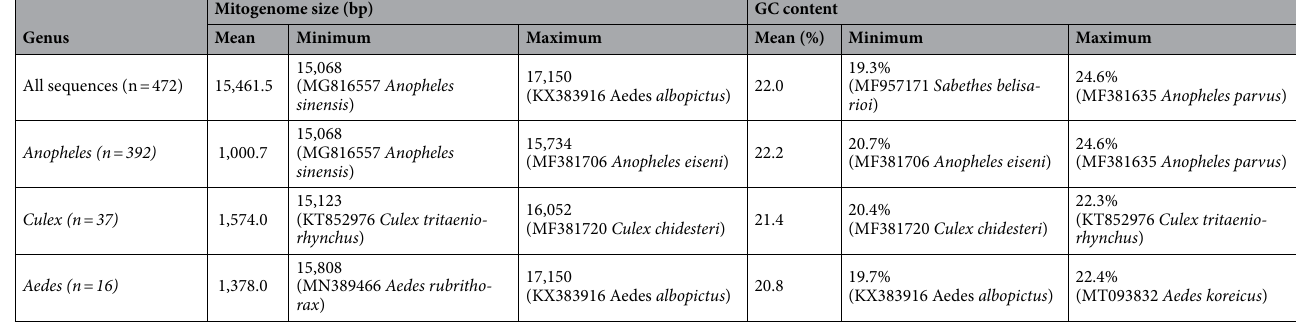
Table 1. Size and GC content of Culicidae mitogenomes by genus.